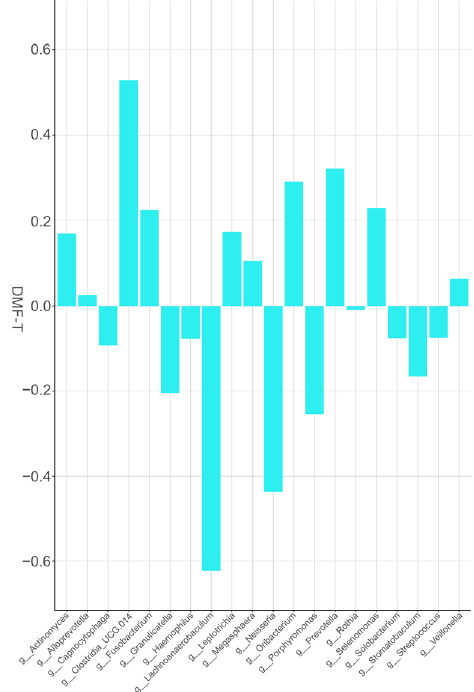
Figure 3. Pearson correlation analysis was performed to measure the associations between the 20 most abundant core genera of the study population and DMF-T (number of decayed, missing and filled teeth). The correlation values range from − 1 to +1.